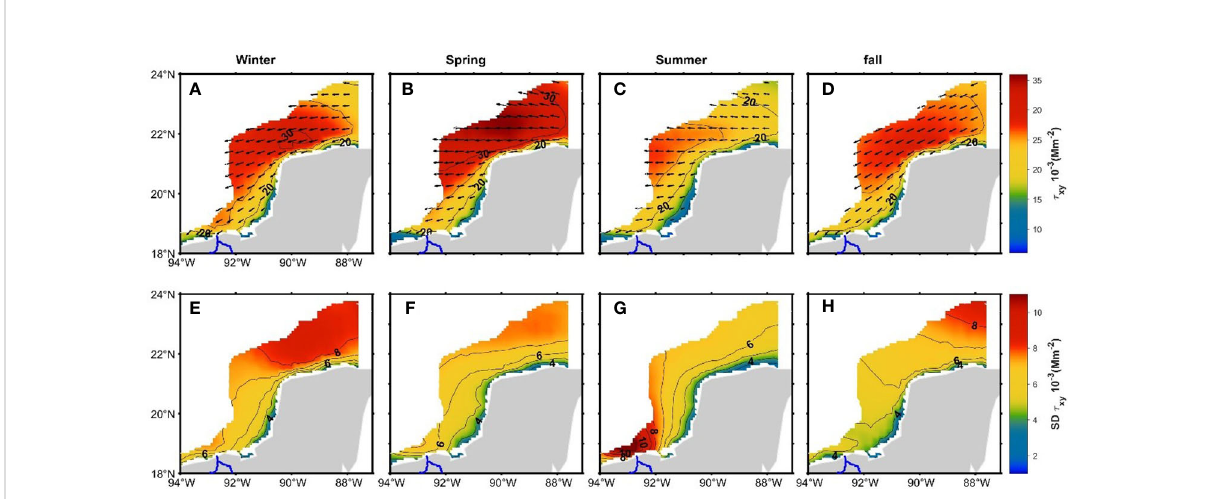
FIGURE 4 Seasonal climatology of wind stress [ t xy · 10 − 3 Nm − 2 ] on the western side of the Campeche shelf and the zonal side of the Yucata ́ n shelf and their respective standard deviation. (A, E) winter, (B, F) spring, (C, G) summer, and (D, H) autumn. The blue outline corresponds to GURS.